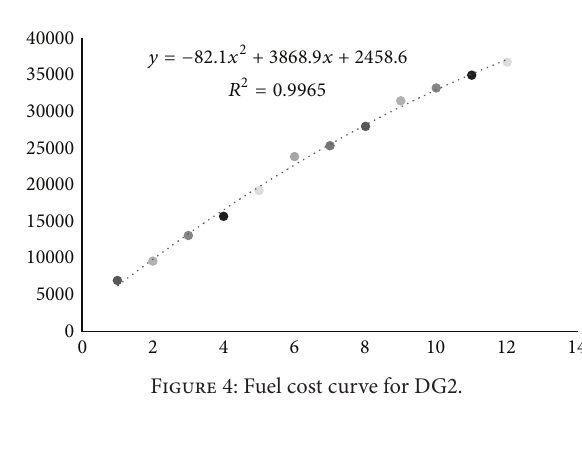
Figure 3: Fuel cost curve for DG1.